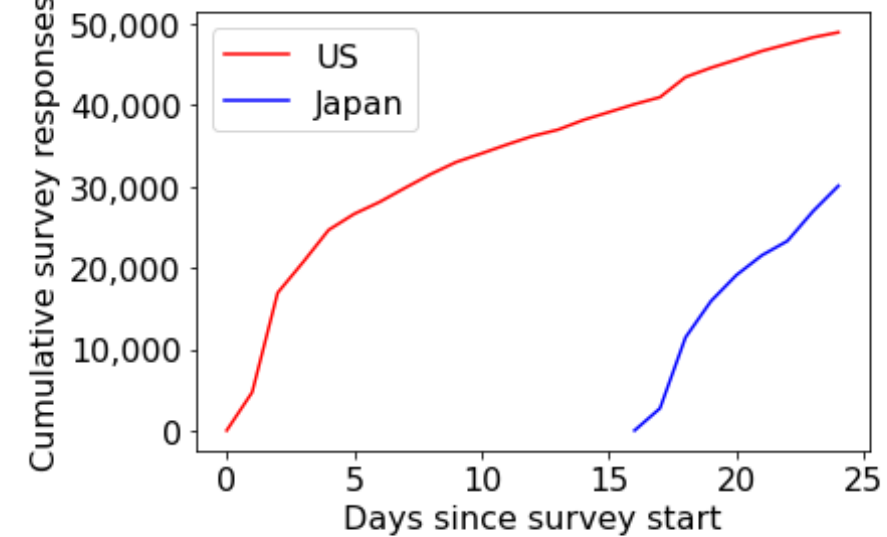
Figure 4. Cumulative responses over time, stratified by location of respondent, to a survey on COVID-19 symptoms. The survey was offered in Japan 16 days after it was introduced in the United